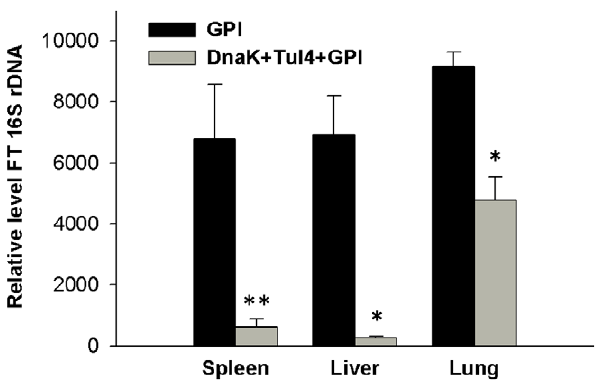
Figure 7. Immunization with subunit vaccine results in reduced bacterial burden. GPI and DnaK + Tul4 + GPI immunized mice were challenged with 1.5 6 10 6 CFU of FT LVS via the i.n. route. The results show the relative levels of FT LVS-specific 16S rDNA present in the spleen, liver and lungs of infected mice five days after infection. There were 4 mice per group and the values are expressed as the mean 6 SEM. Significant differences were seen at P , 0.01 (*) and P , 0.05 (**) compared to mice immunized with GPI